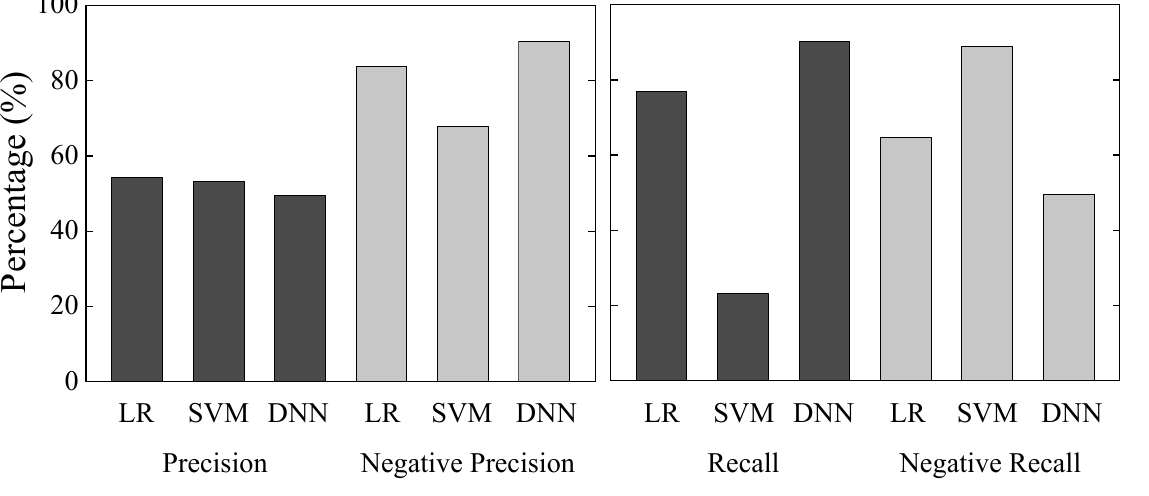
Figure 8. Comparison of Precision, Negative Precision, Recall, and Negative Recall in Section 3.5.